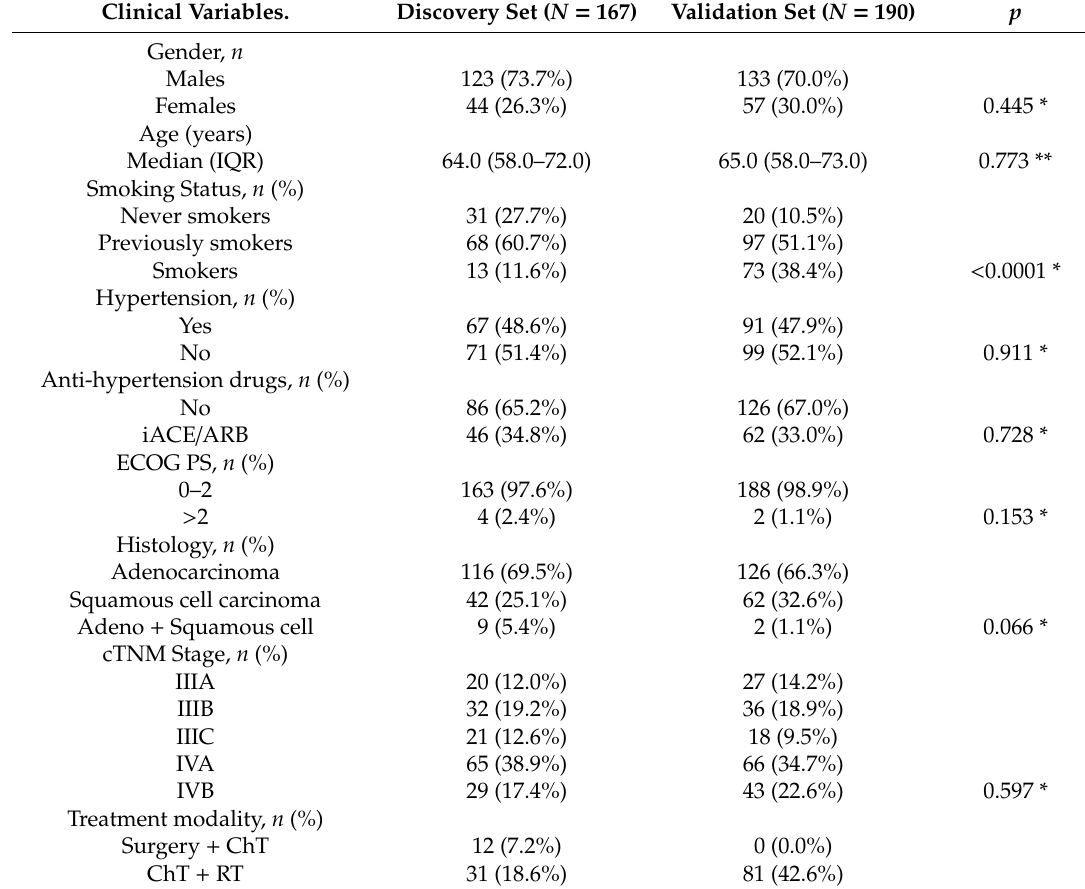
Table 1. Patient (cid:48) s clinical